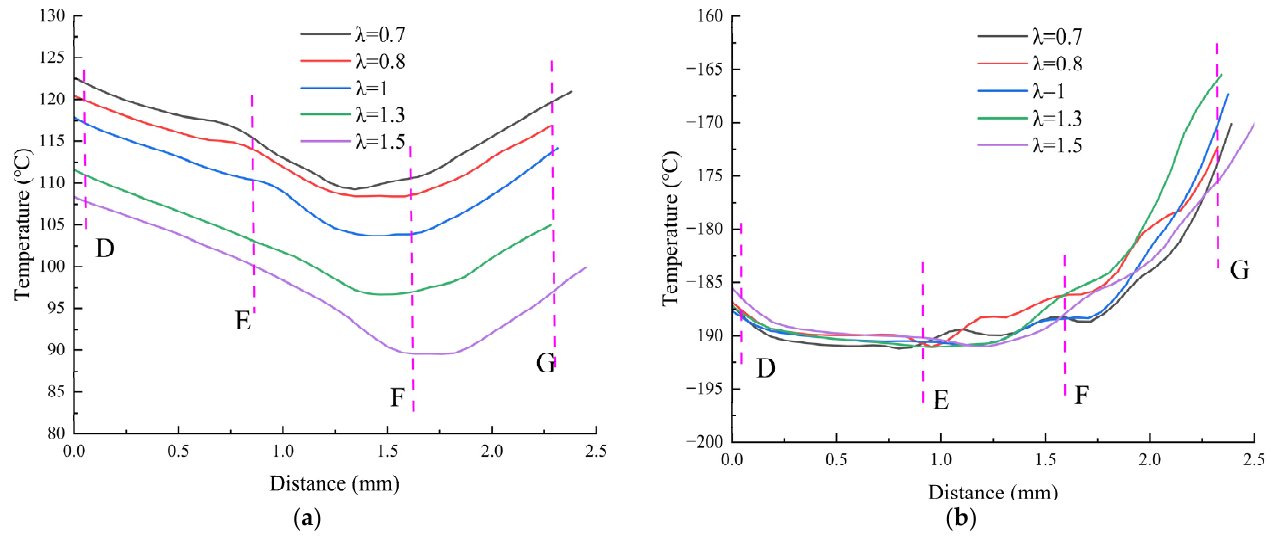
Figure 7. Variation curves of temperature of the fins along the trajectory direction under different conditions: ( a ): RT-EM; ( b ): CT-EM.